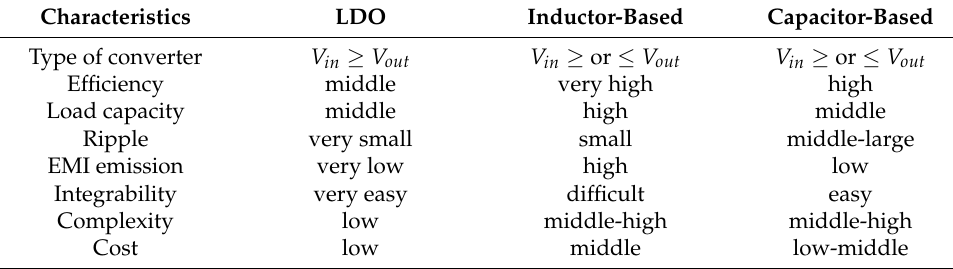
Table 2. Comparison of DC/DC converter for solar energy